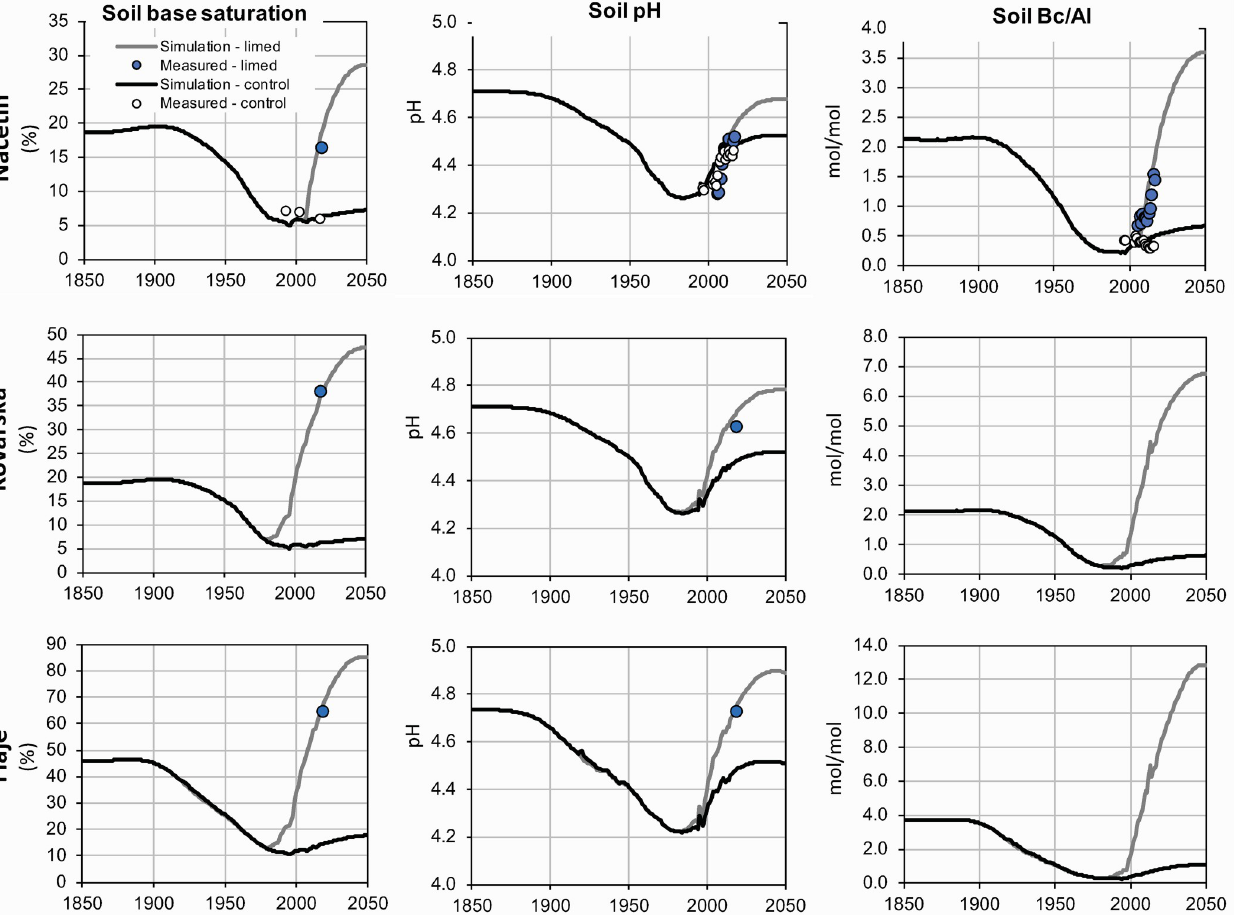
Fig 8. Modelled and measured (a) soil base saturation, (b) soil solution pH and (c) soil solution Bc/Al ratio (1850–2050) for all investigated sites.